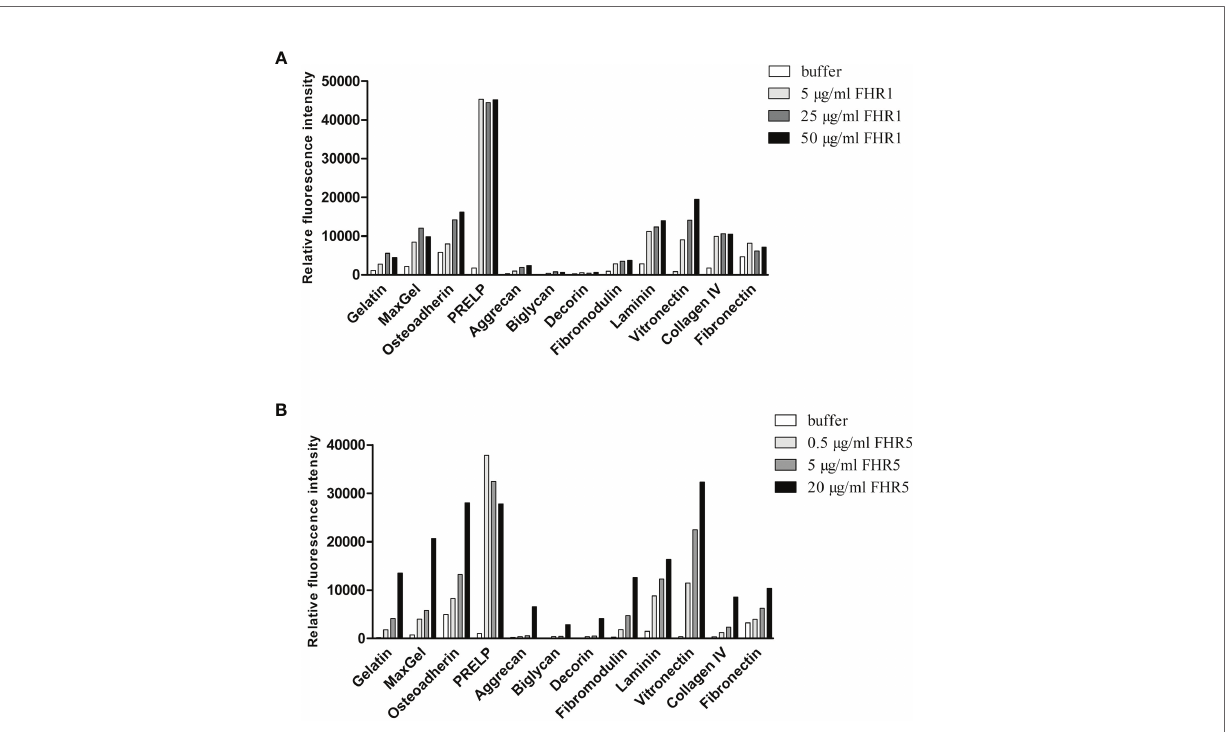
FIGURE 2 | Binding of FHR1 and FHR5 to ECM components. FHR1 (A) and FHR5 (B) binding to ECM ligands was analyzed by protein microarray. ECM proteins, gelatin and MaxGel were printed onto nitrocellulose-covered slides in triplicates. Air-dried slides were washed and blocked with 4% BSA, then incubated with FHR1 or FHR5 in increasing concentrations. Bound proteins were detected with polyclonal goat anti-human FH or polyclonal goat anti-human FHR5 Ab and Alexa-647 labeled goat-IgG. A signal higher than the one obtained for the negative control protein gelatin was de fi ned as the threshold for binding. Data are representative of two